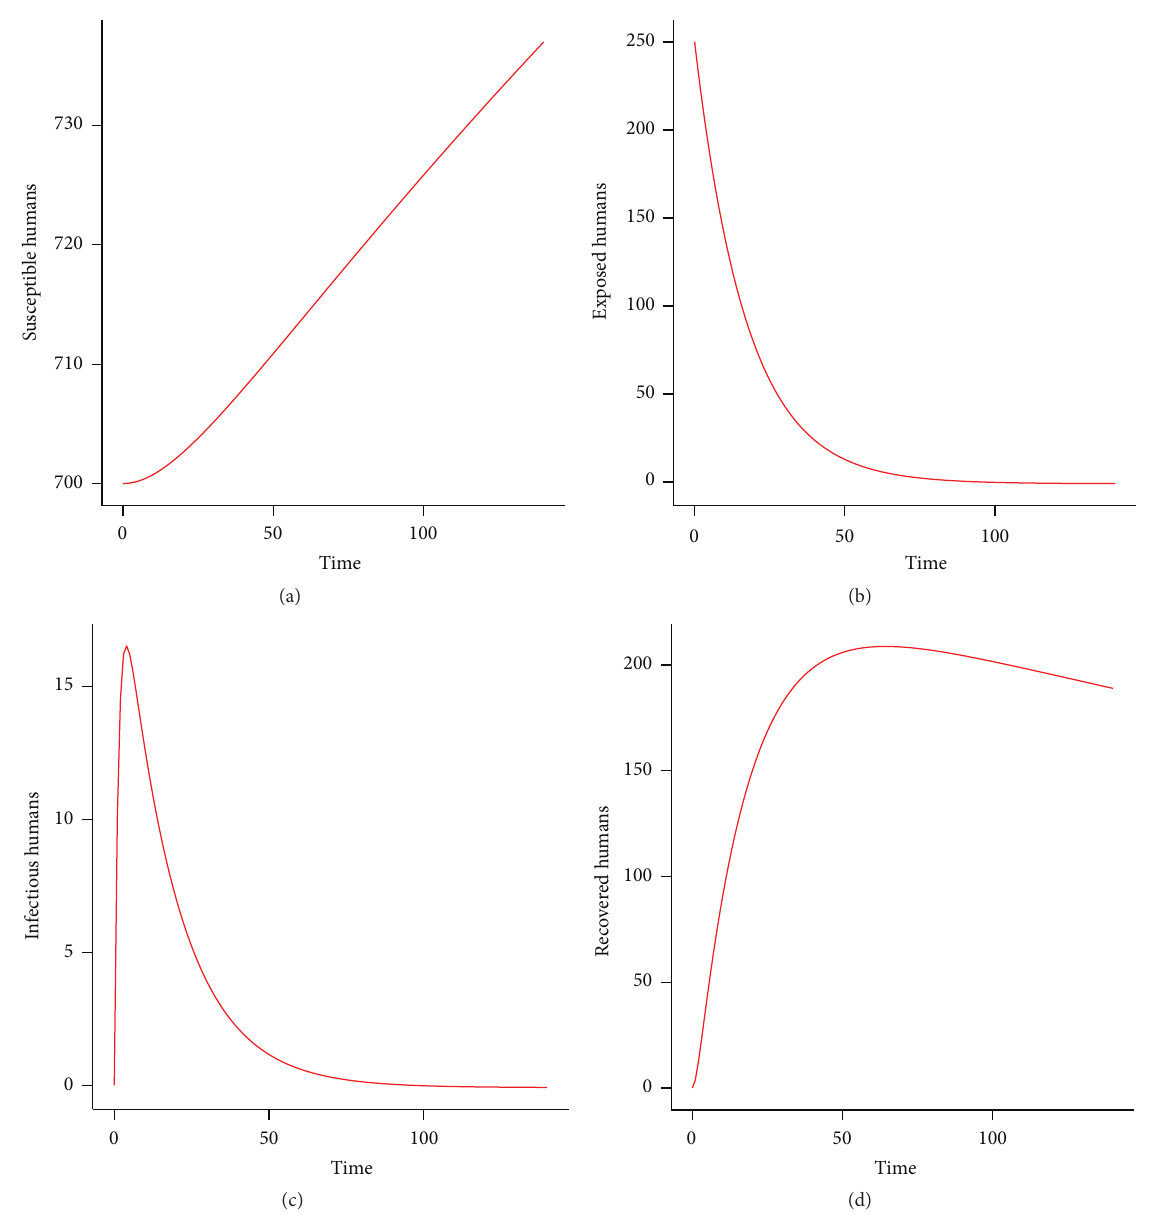
function 𝐽 while setting the control on treatment ( 𝑢 2 ) and control on ITNs ( 𝑢 1 ) to